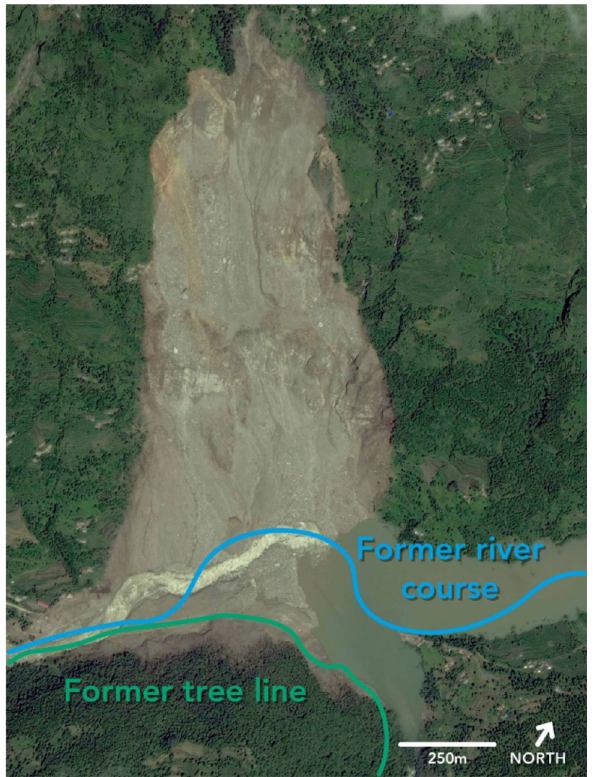
Fig. 1 The extent of the 2 August 2014 Jure landslide, indicating the former river course and tree line. Source Google Earth.